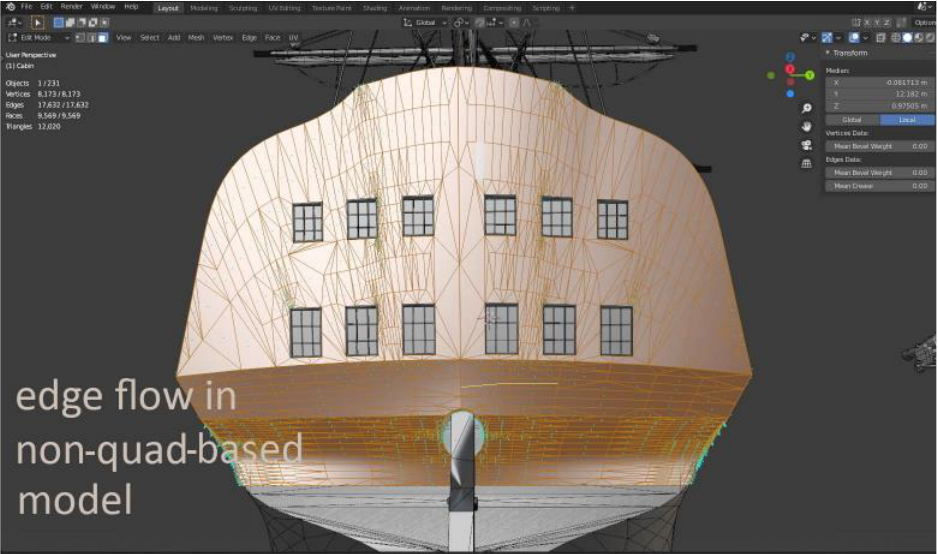
Figure 7 . A non-quad-based model before retopology. Screenshot from Blender.